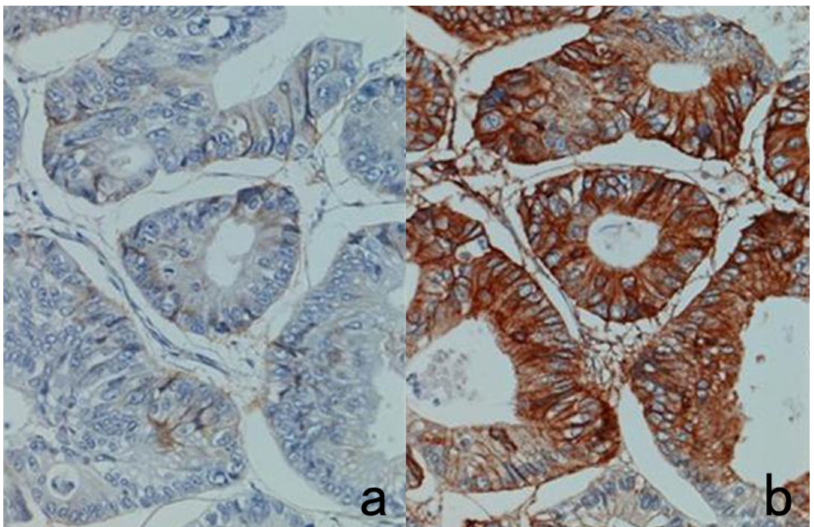
Figure 28. PharmDx TM for EGFR immunostaining in colonic adenocarcinoma. The kit supplied from Agilent/Dako provides faint immunoreactivity ( a ), which may affect appropriate judgment. However, when replacing EnVision (as the secondary reagent) with CSA-II (available from the same company), very strong EGFR immunoreactivity can be observed ( b